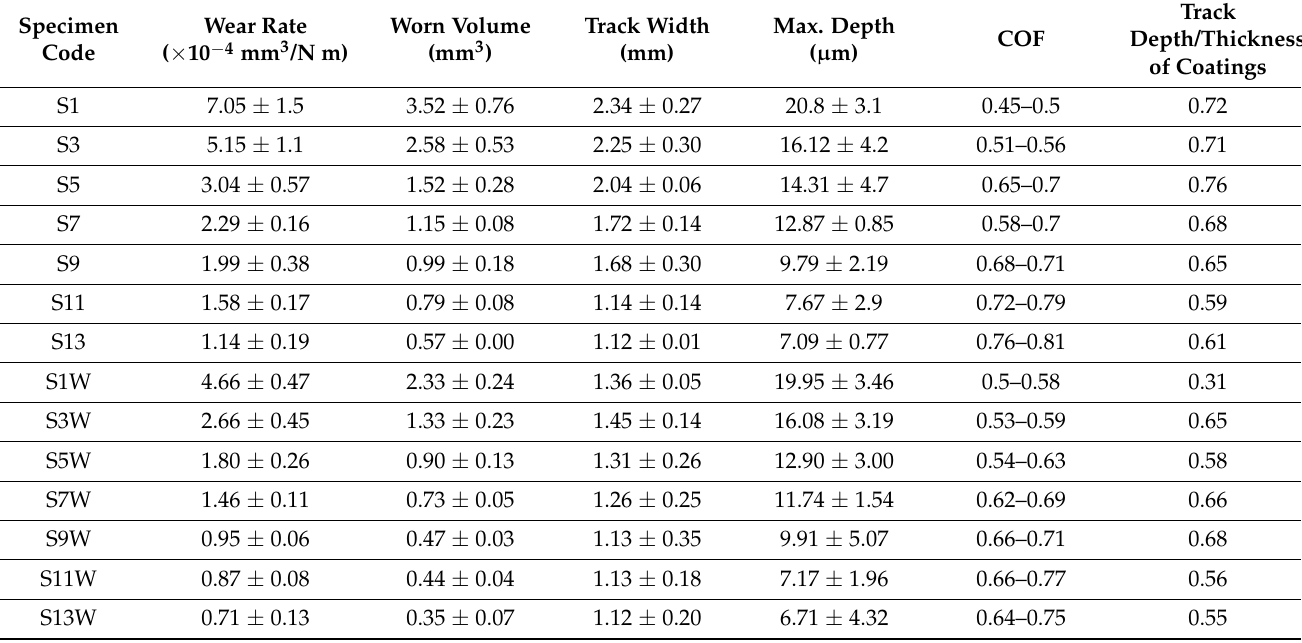
Table 2. Wear tracks’ specifications obtained by analysis of line profile